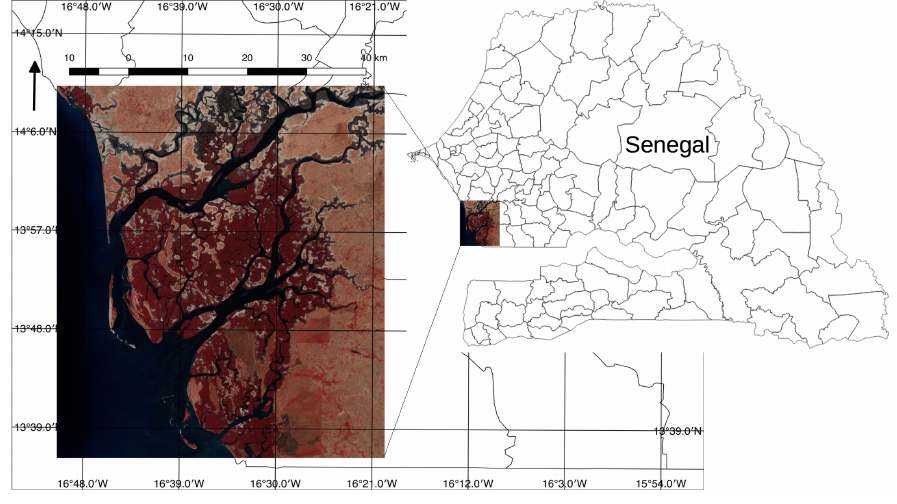
Figure 1. Saloum river delta in